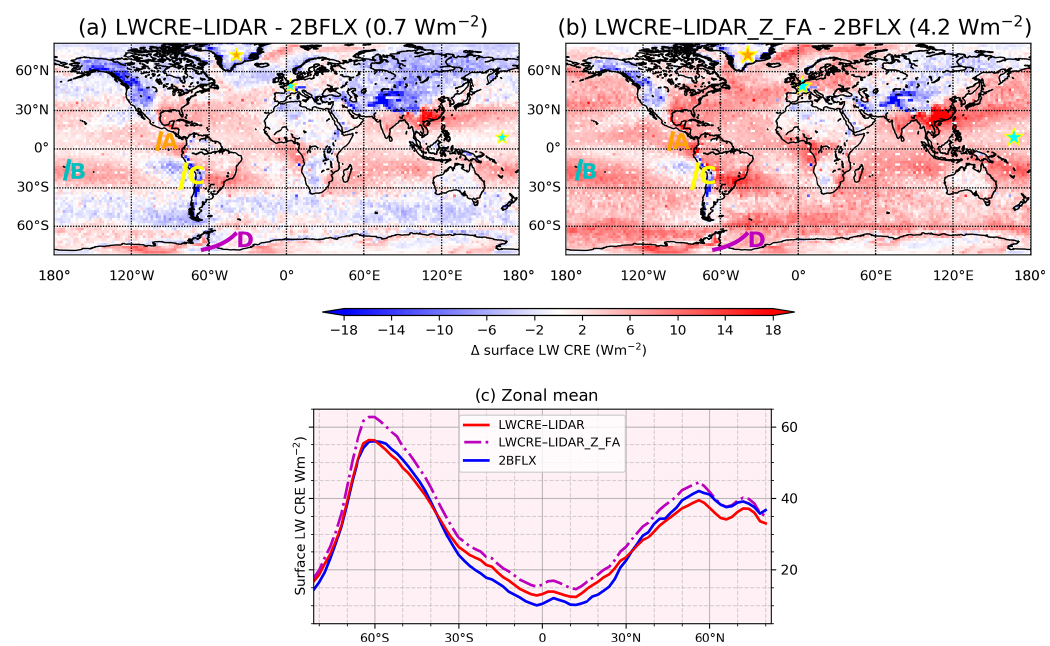
Figure 14. Maps of differences in the surface LW CRE (a) LWCRE–LIDAR minus 2BFLX, (b) LWCRE–LIDAR_Z_FA minus 2BFLX, and (c) zonal means of the two satellite products. Data are averaged over 2008–2010. Locations of the three ground-based sites and pieces of orbits are reported on the